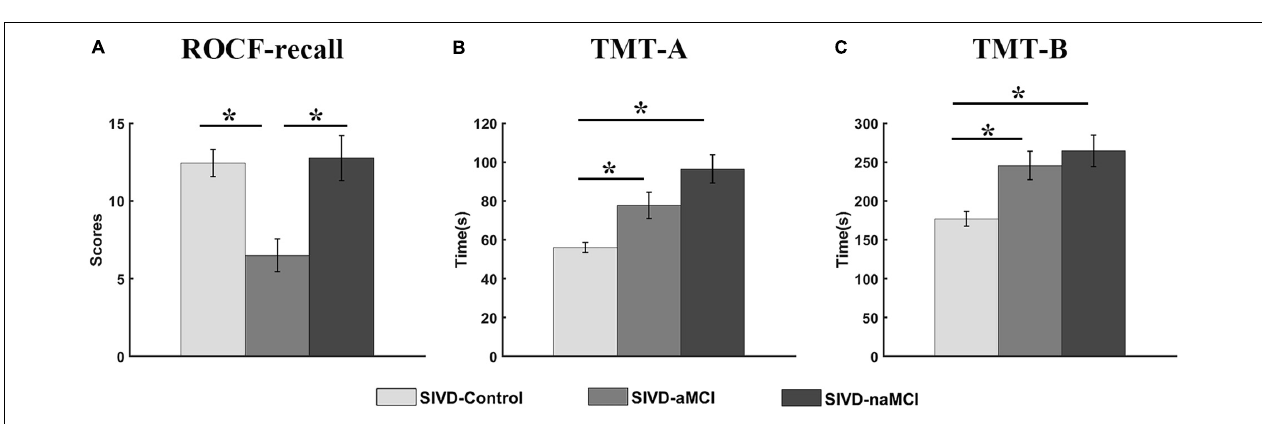
FIGURE 4 | Neuropsychological assessments of ROCF-recall (A) , TMT-A (B) and TMT-B (C) for the three groups. *Represents p <